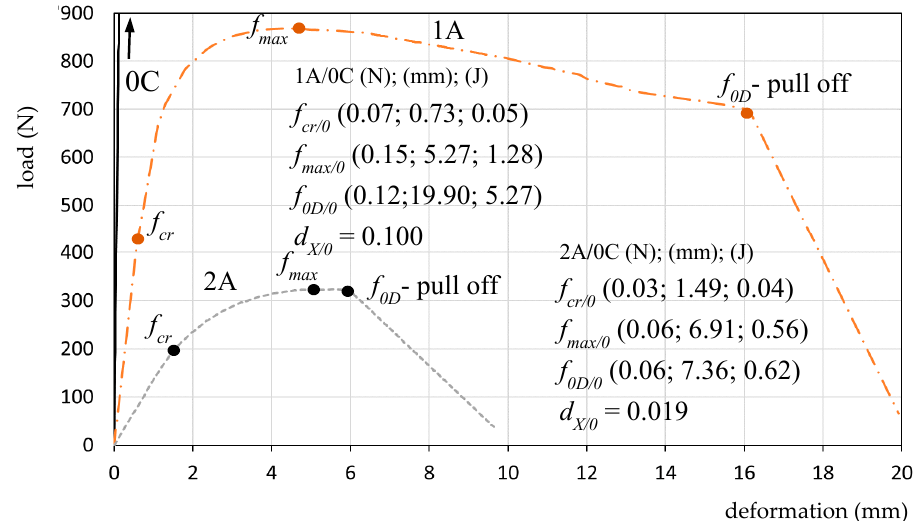
Figure 11. The load–deformation curves for specimens 1A, 2A and specimen 0C.